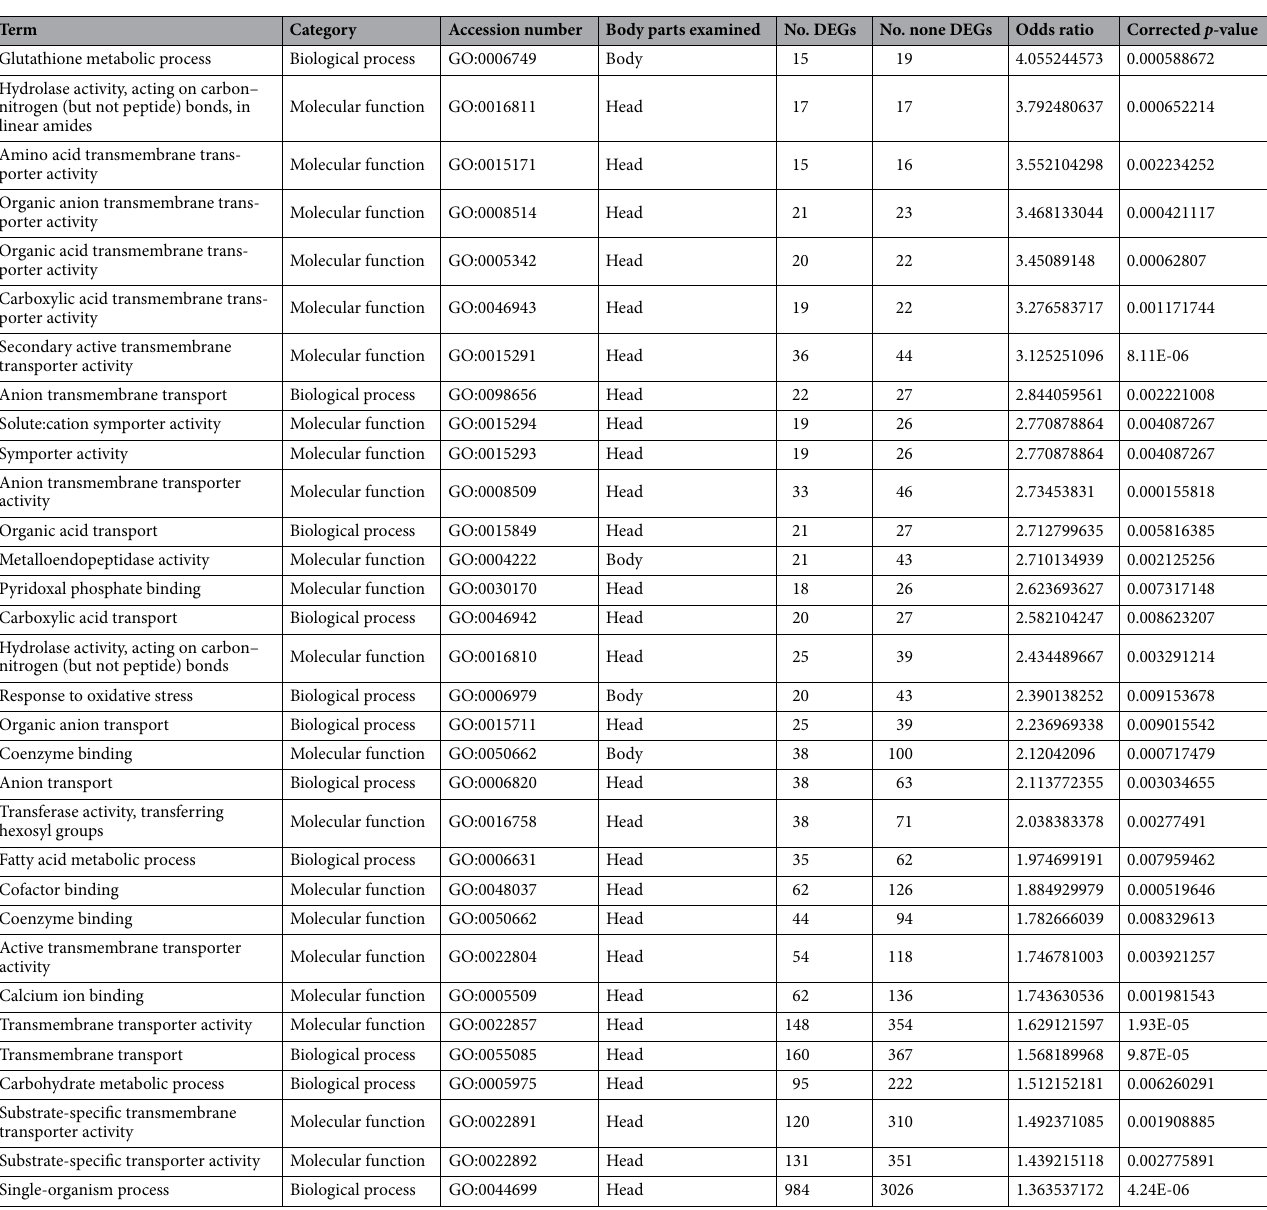
Table 1. Gene Ontology (GO) terms specifically observed during the worker-worker